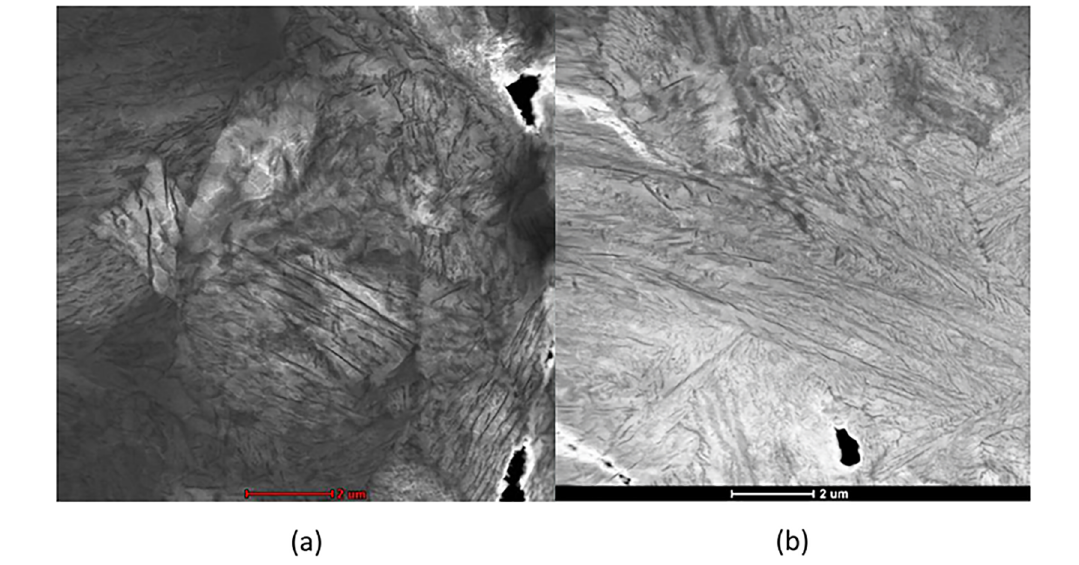
Figure 11. Mixed microstructure at 10 mm from tread surface. a) Pearlite; b) Bainite.